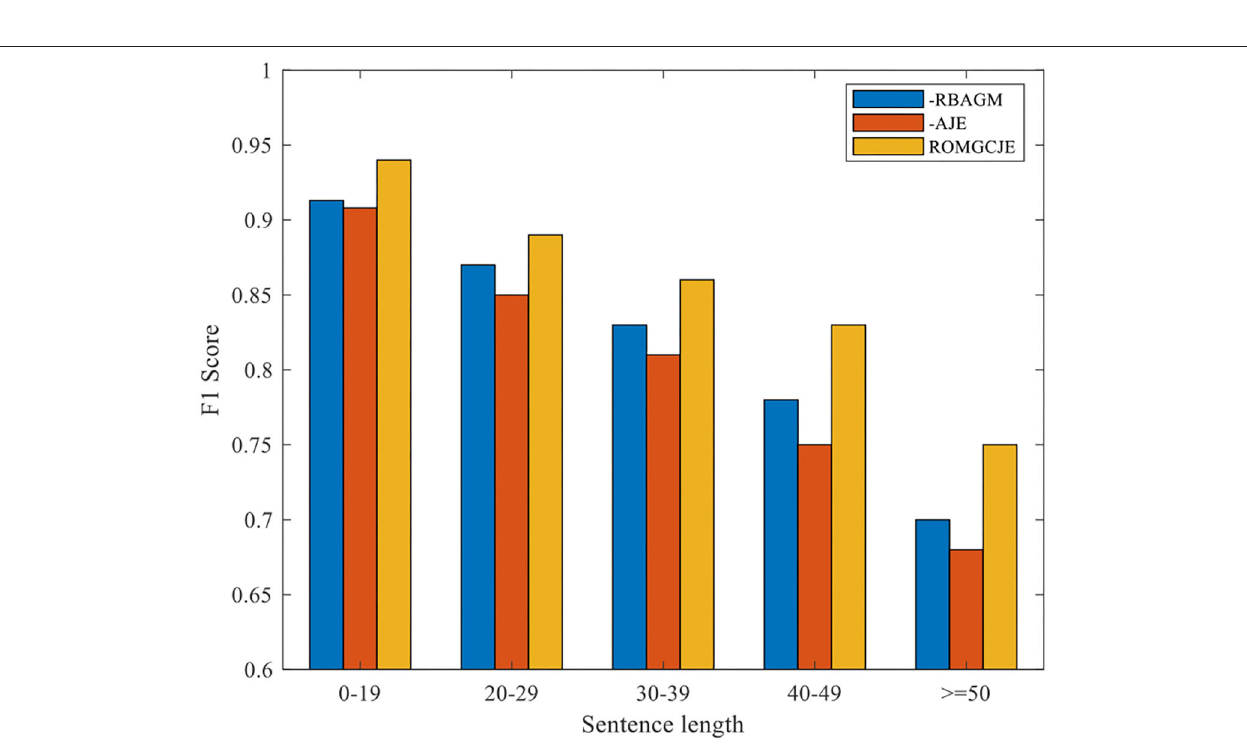
Frontiers in Neurorobotics |